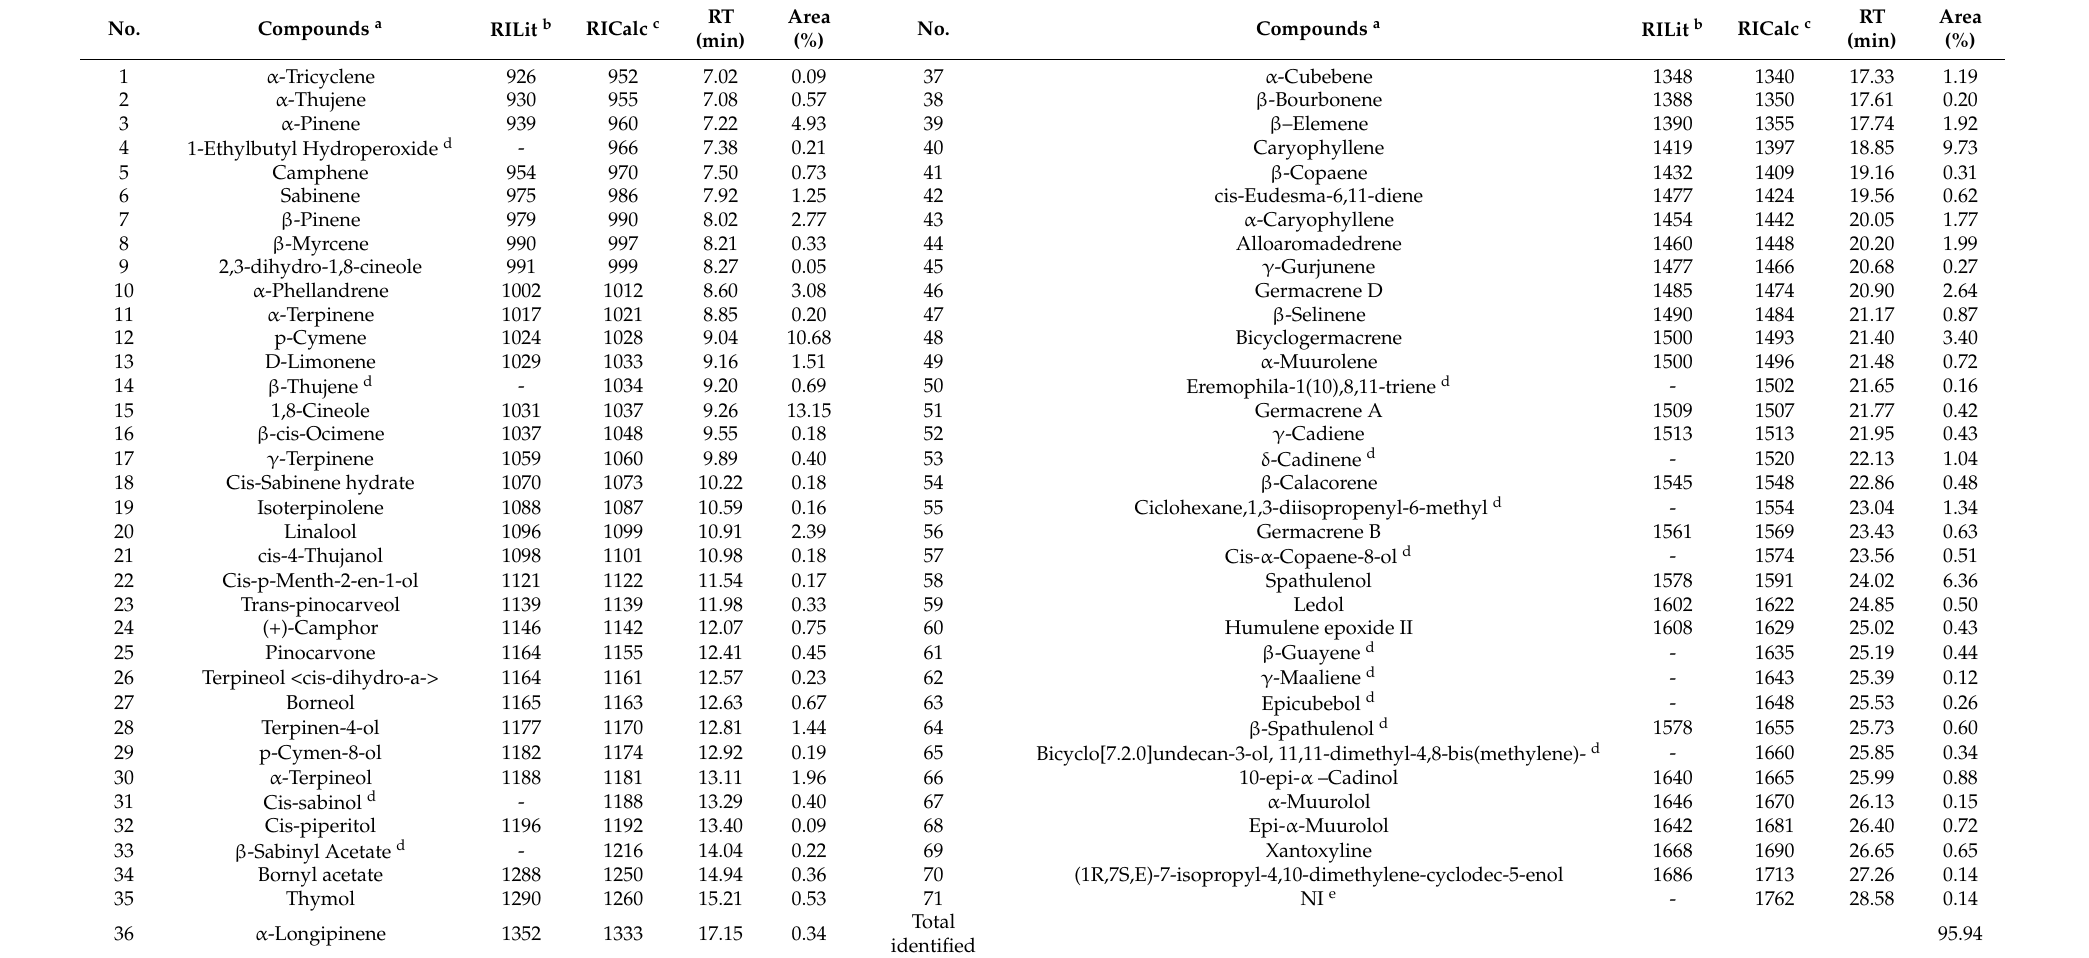
Table 1. Chemical constituents of Croton conduplicatus essential